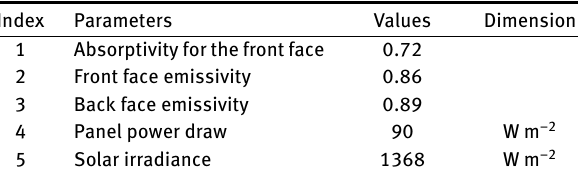
Table 2. Thermal characteristics of the GPS Block IIR solar panels